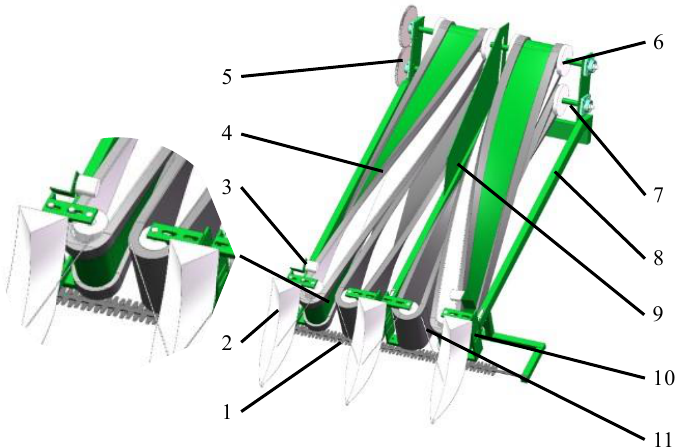
Figure 1. Schematic diagram of the key structure of the rape shoots harvesting device: 1. cutting device; 2. crop divider; 3. suppression wheel; 4. flexible clamping conveyor belt; 5. synchronous transmission gear; 6. discharge port; 7. clamping belt power input shaft; 8. frame; 9. separation partition; 10. belt tensioning and clamping spacing adjustment device; 11. feeding port.